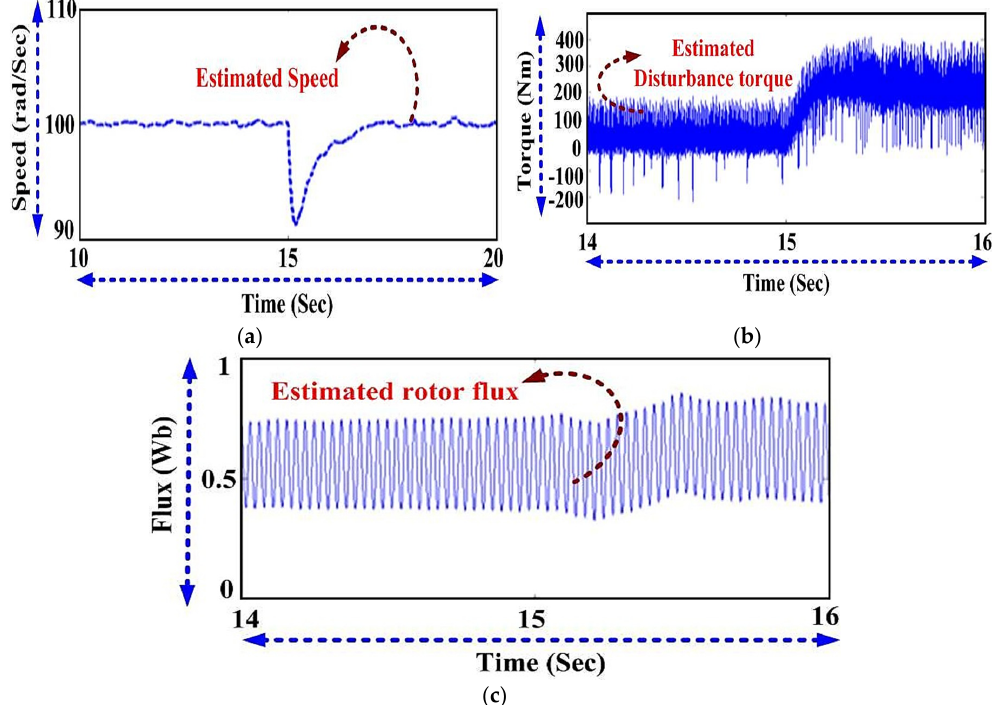
Figure 8. SMLO2: ( a ) estimated speed; ( b ) estimated torque and ( c ) estimated rotor flux.